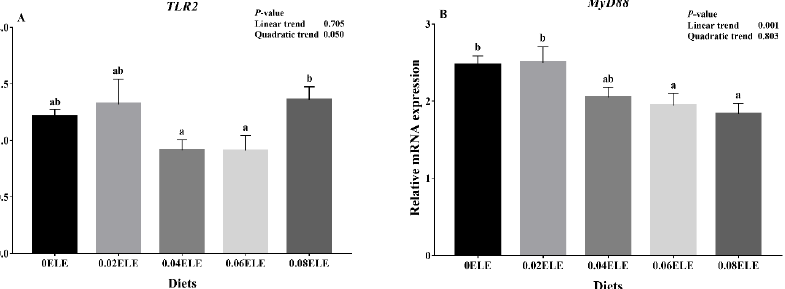
Figure 3 . Relative expressions of TLR2 - MyD88 signaling pathway with different ELE levels. TLR2 ( A ); MyD88 ( B ). Data are expressed as means ± S.E.M., value with different letters (a, b) are significantly different ( p < 0.05).